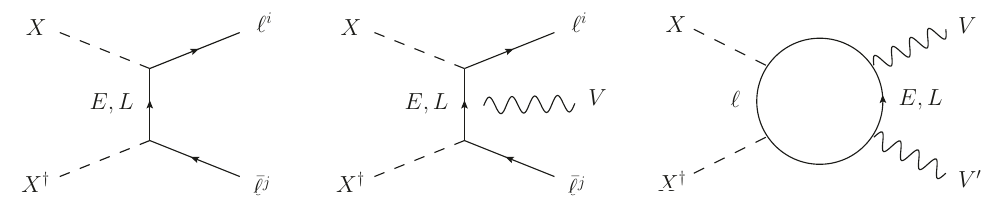
Figure 3 . Example diagrams of the DM pair annihilation in the scalar DM model. In the fermion DM model, the dashed lines for X and solid lines for E and L are replaced by the solid lines for (cid:31) and dashed lines for e E and e L ,